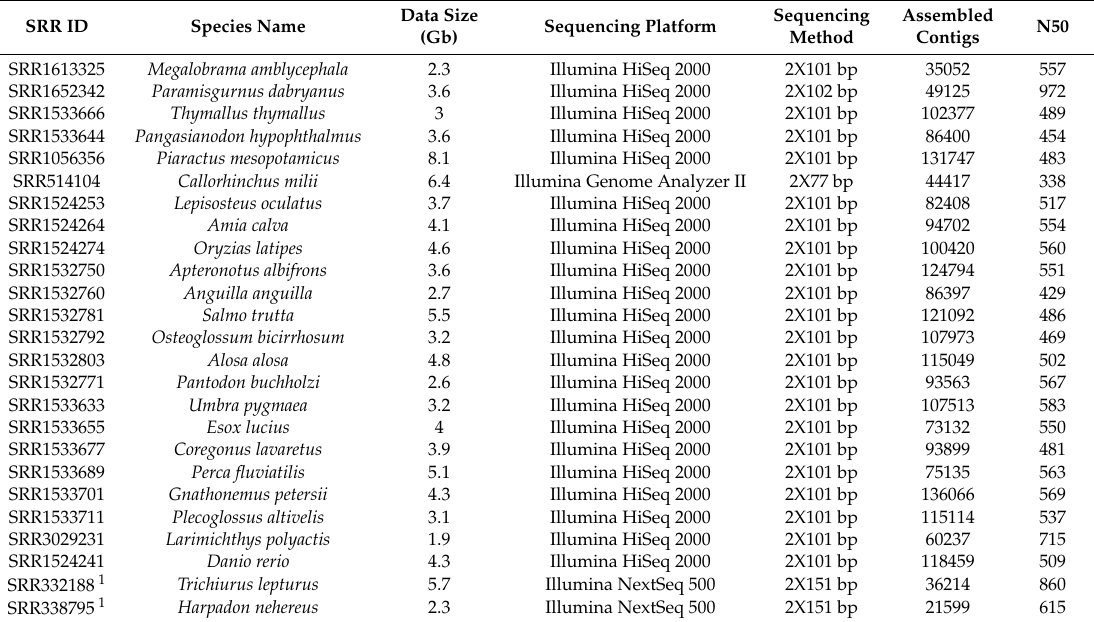
Table 1. Summary of the fish species and muscle transcriptomic data used in this